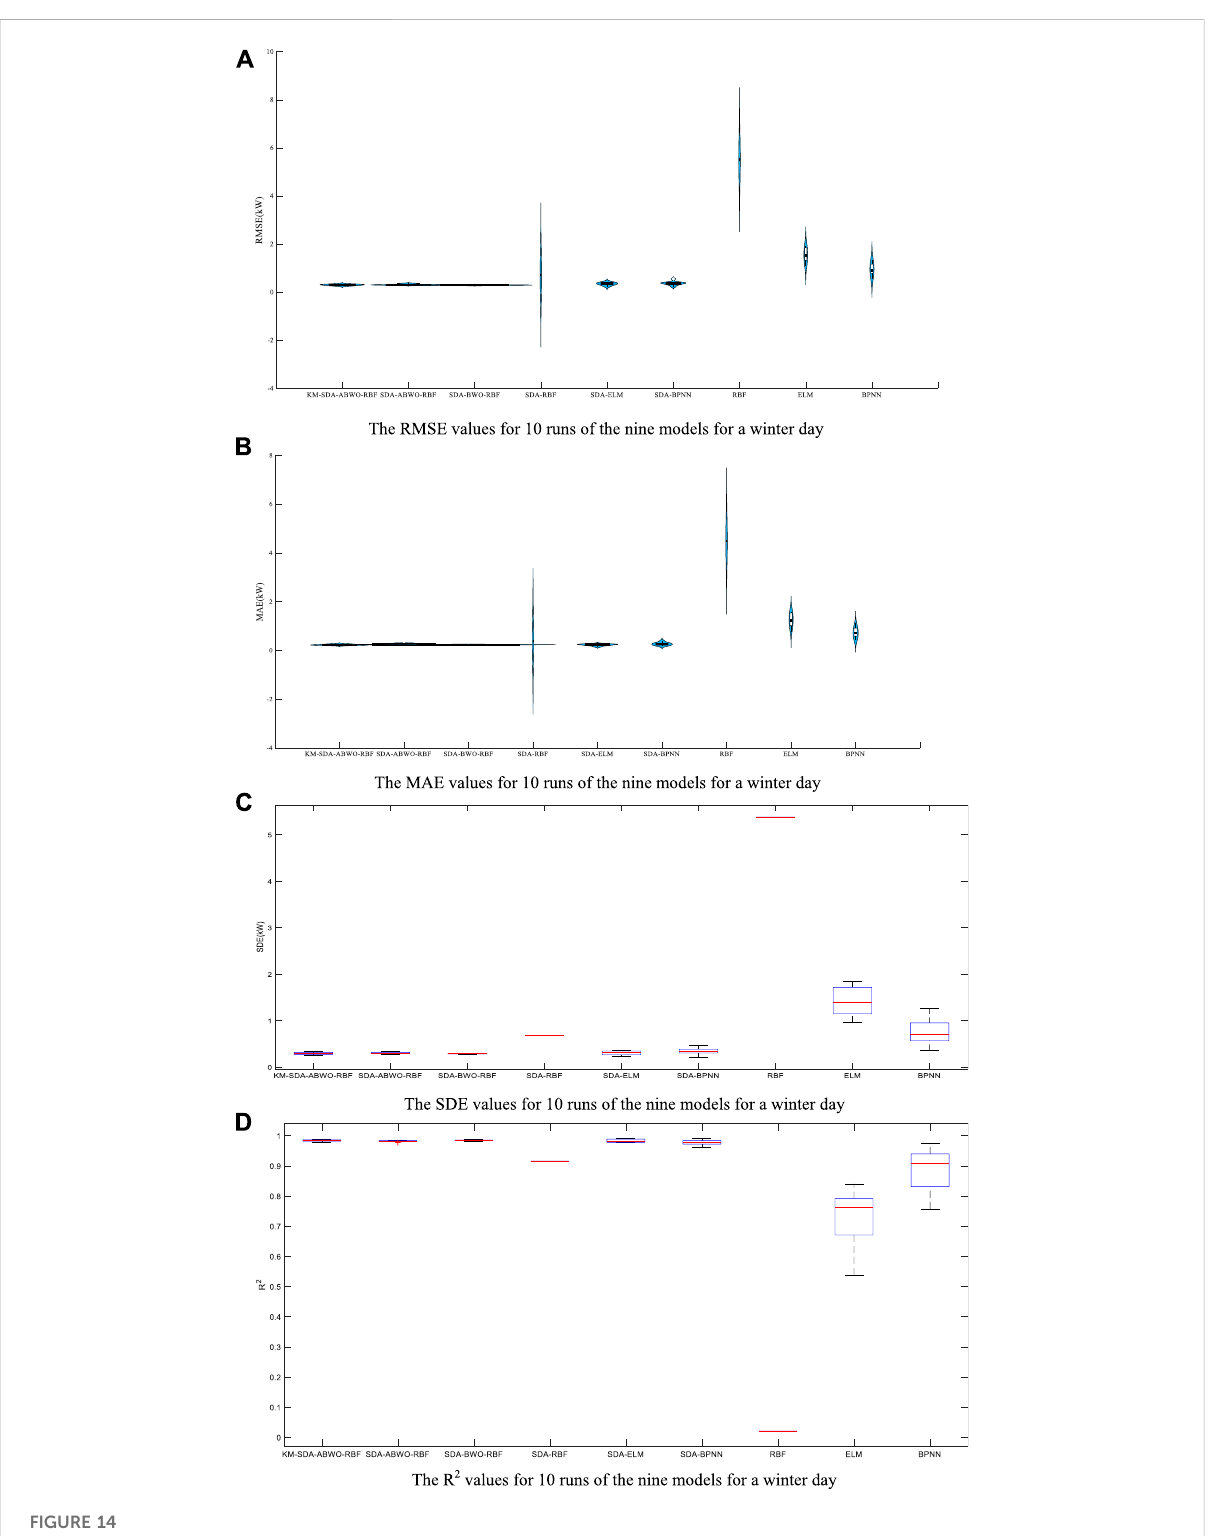
FIGURE 14 (A – D) show the RMSE, MAE, SDE, and R 2 values for 10 runs of 9 models for a winter